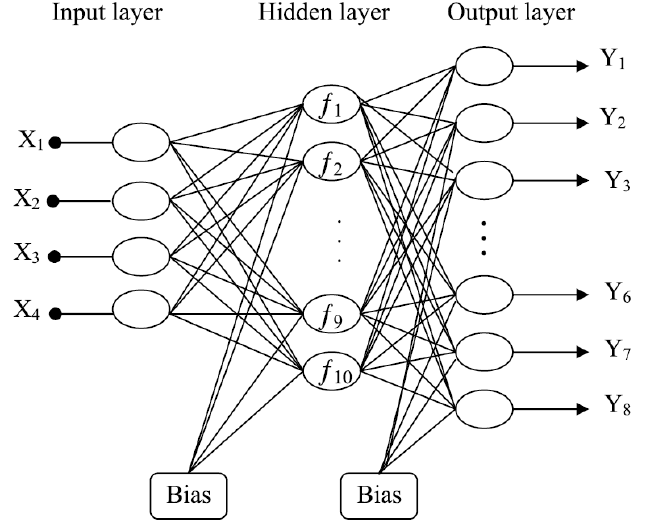
Figure 3. Scheme of the artificial neural network with indicated layers, weights, functions [51]. Reprinted with permission from Taylor & Francis.